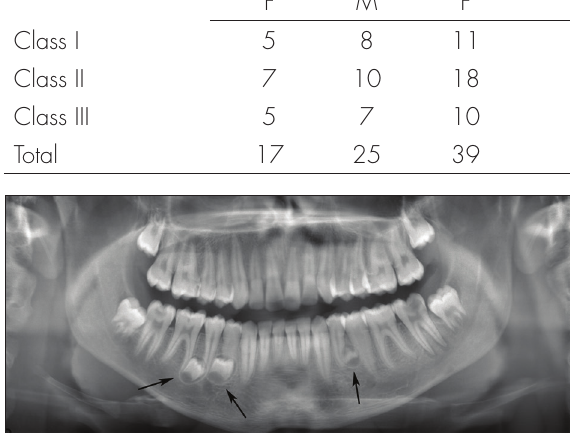
Figure 1. Panoramic radiograph of patient aged 16 years (case 7). This patient has three supernumerary premolars with early crown formations in the mandible (arrows).